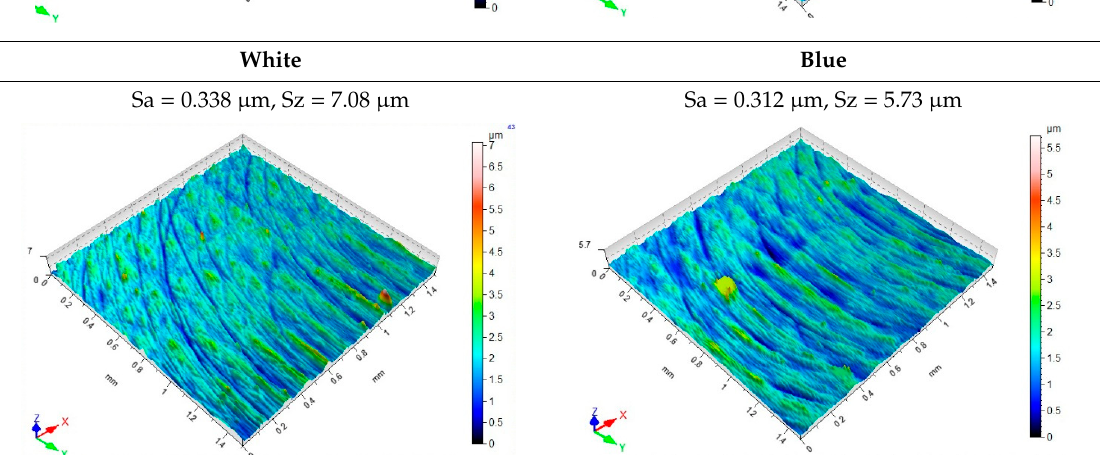
Figure 13. View of the surface after milling.